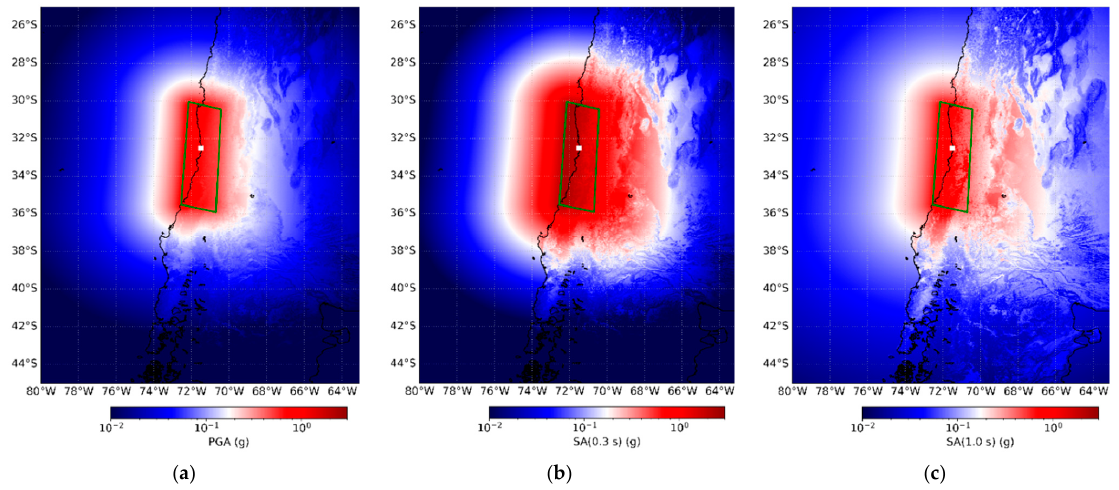
Figure 12. Median values of the Mw 9.1 earthquake for the three IMs of ( a ) PGA, ( b ) S.A(0.3 s), and ( c ) S.A(1.0 s) using the Montalva et al. (2017) GMPE [92] and the seismic microzonation available for the area [95].The earthquake hypocentre is shown as a white dot. The rupture plane is represented by a green rectangle.